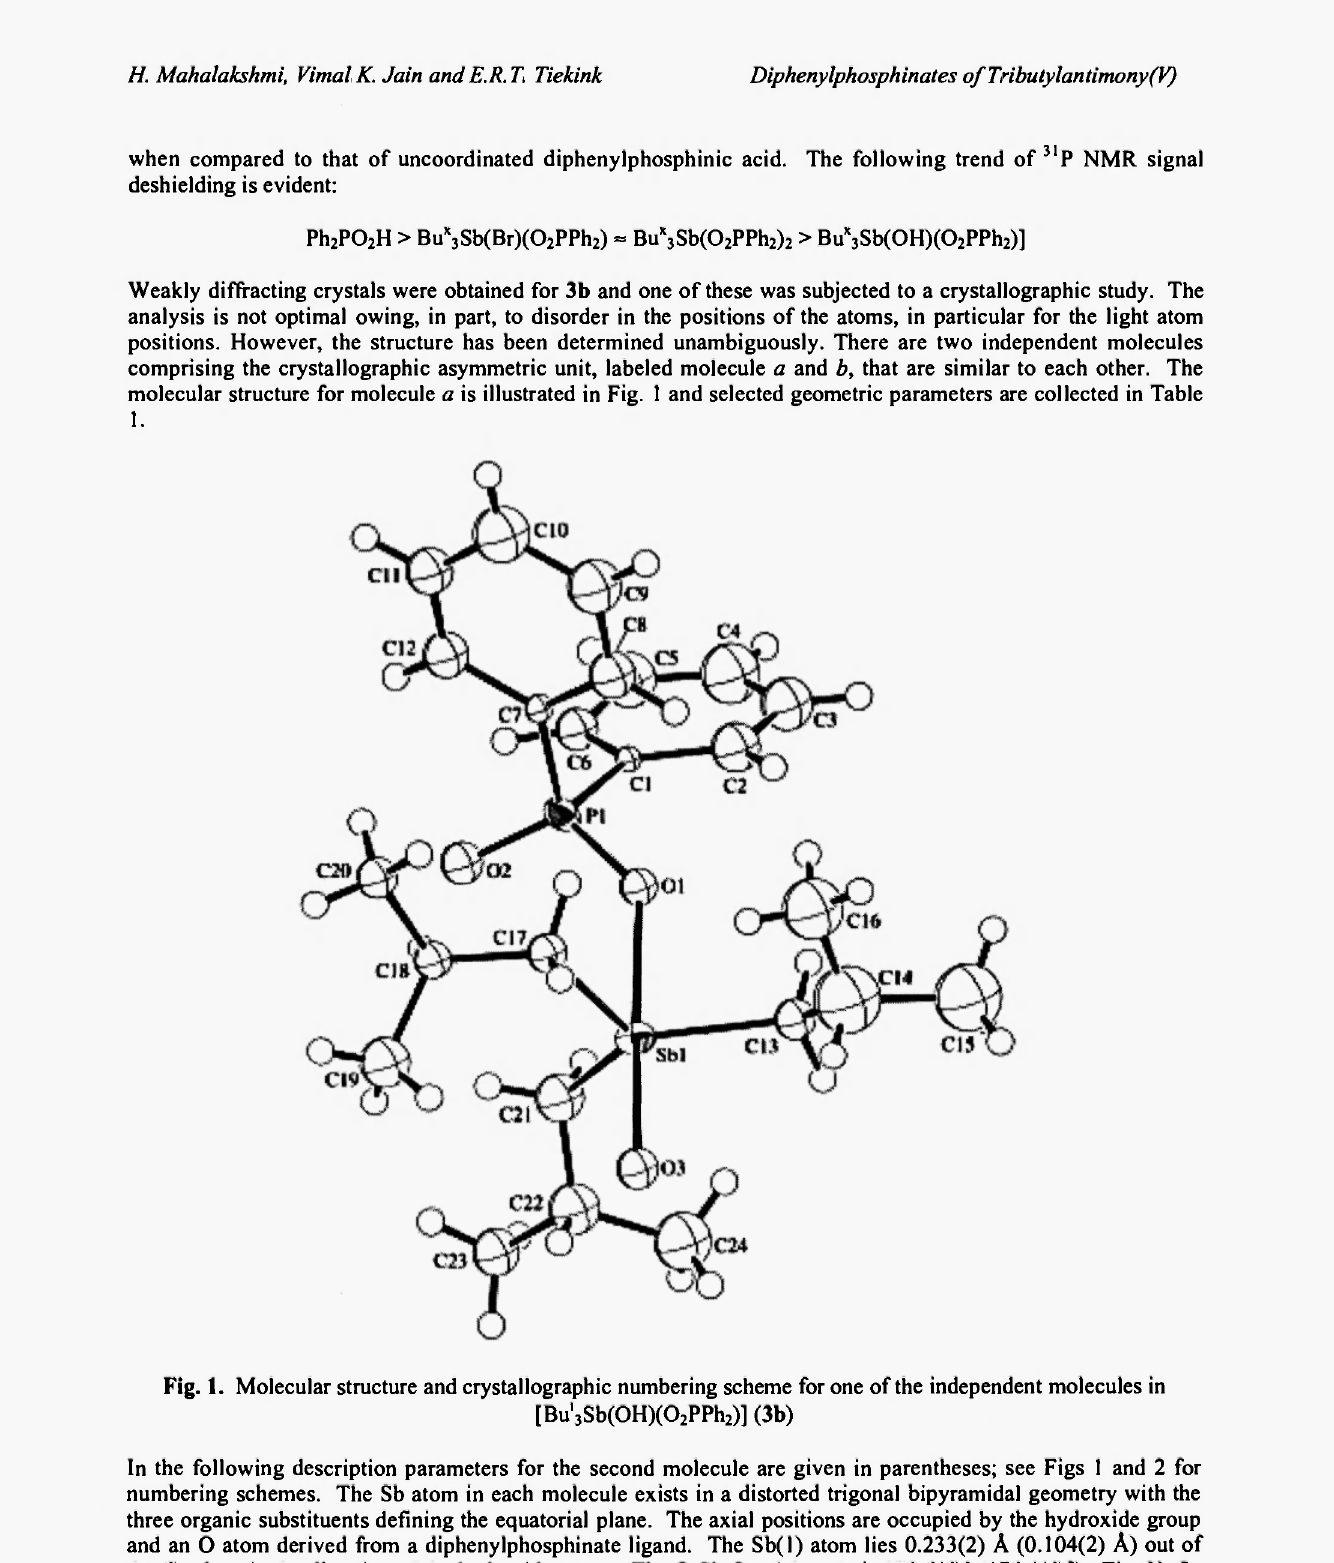
Fig. 1. Molecular structure and crystallographic numbering scheme for one of the independent molecules